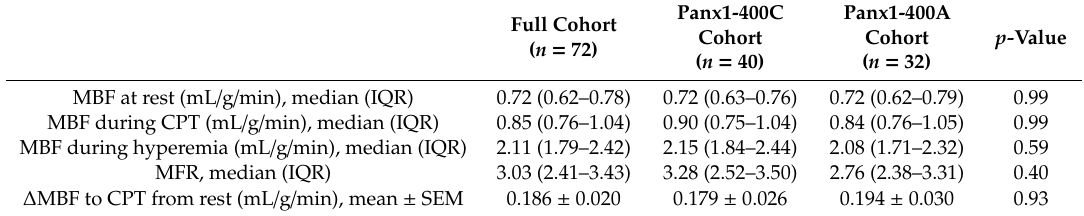
Table2. MBF,MFR,andendothelialfunctionmeasuredduring 13 N-ammoniaPET /